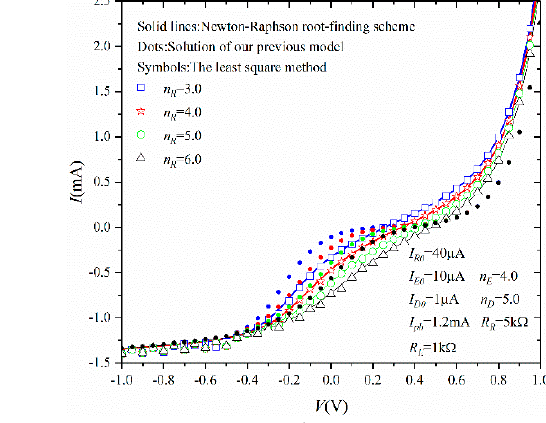
Figure 8. ( a ) V int ( V ) and ( b ) I ( V ) of the circuit in Figure 2 for different I E 0 .